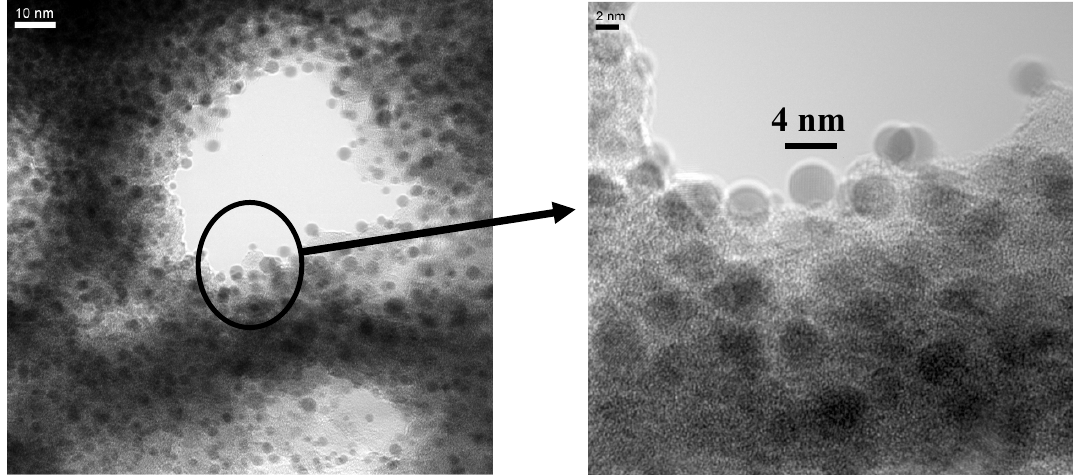
Figure 38. HRTEM-image showing small Ni-particles with a size between 2 nm and 5 nm covering the walls of the porous silicon skeleton. Right: enhanced region of the left image showing these small spherical Ni particles in